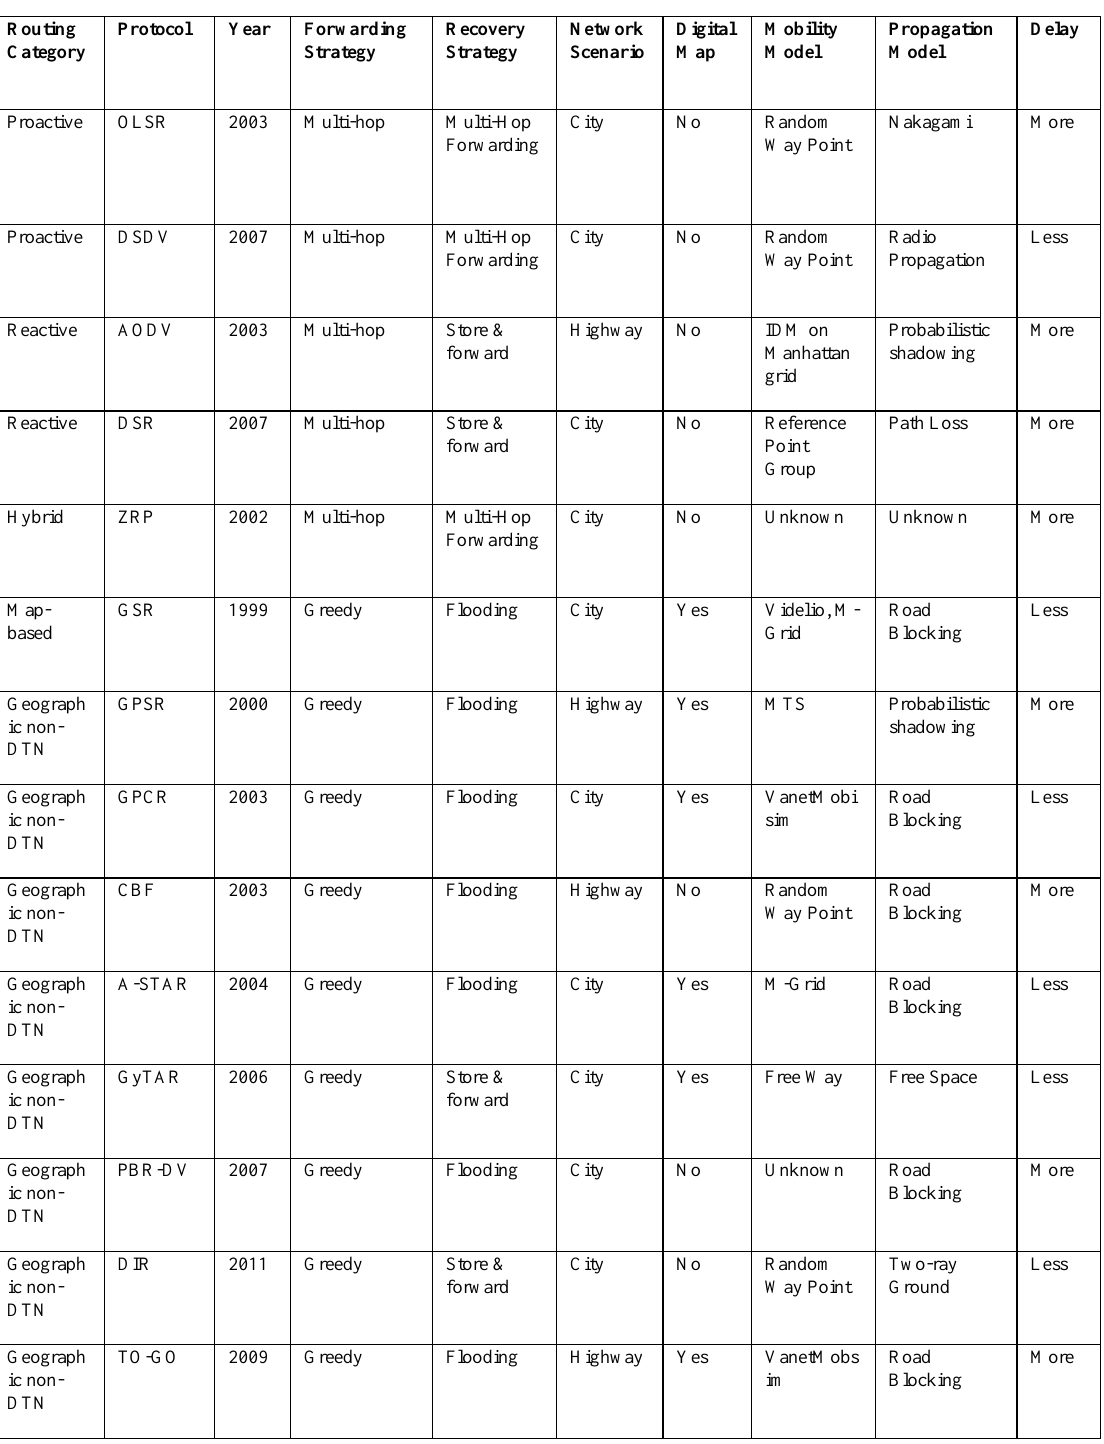
Table 1. Summary of VANET routing